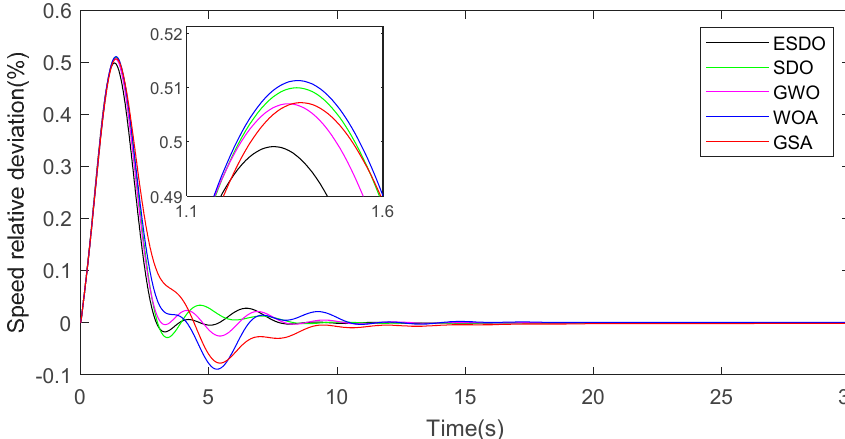
Figure 11. Speed response curves with 4% load.